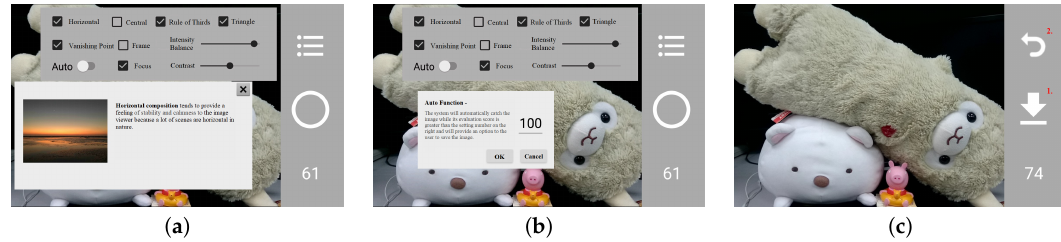
Figure 26. ( a ) Explanation for a composition method. ( b ) The setting of a score value, and when the evaluation score is equal to or greater than this score, the photo will be automatically taken, and the interface will be changed to ( c ).